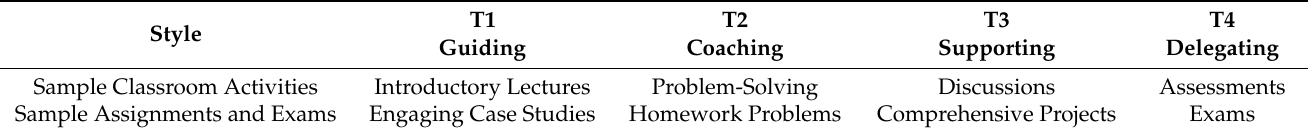
Table 1. A sample matrix of teaching styles and activities, after Hersey et al. (1982) and Tehrani (2011)